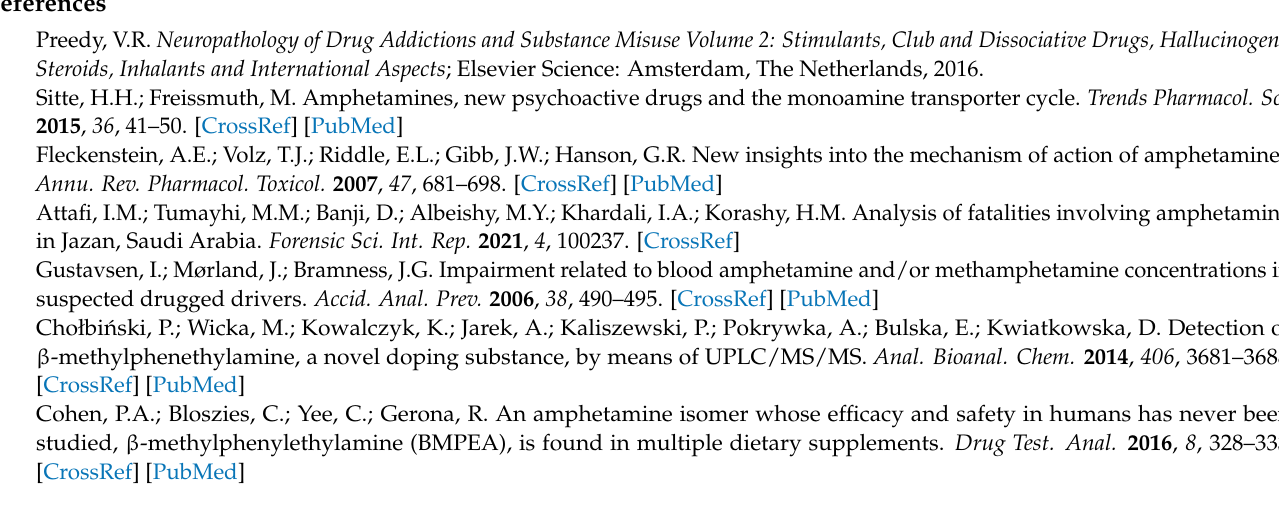
blood; Table S4: Summary of analytical performance parameters; Table S5: Analyte stability data for amphetamine-related drugs at three different concentrations